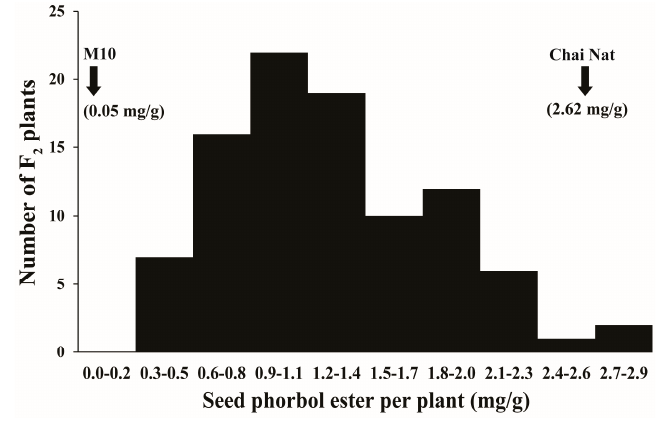
Figure 2. Frequency distribution of phorbol esters content in seeds (mg per gram) of the 95 F 2 plants derived from the cross Chai Nat × M10. PE was determined by HPLC method.